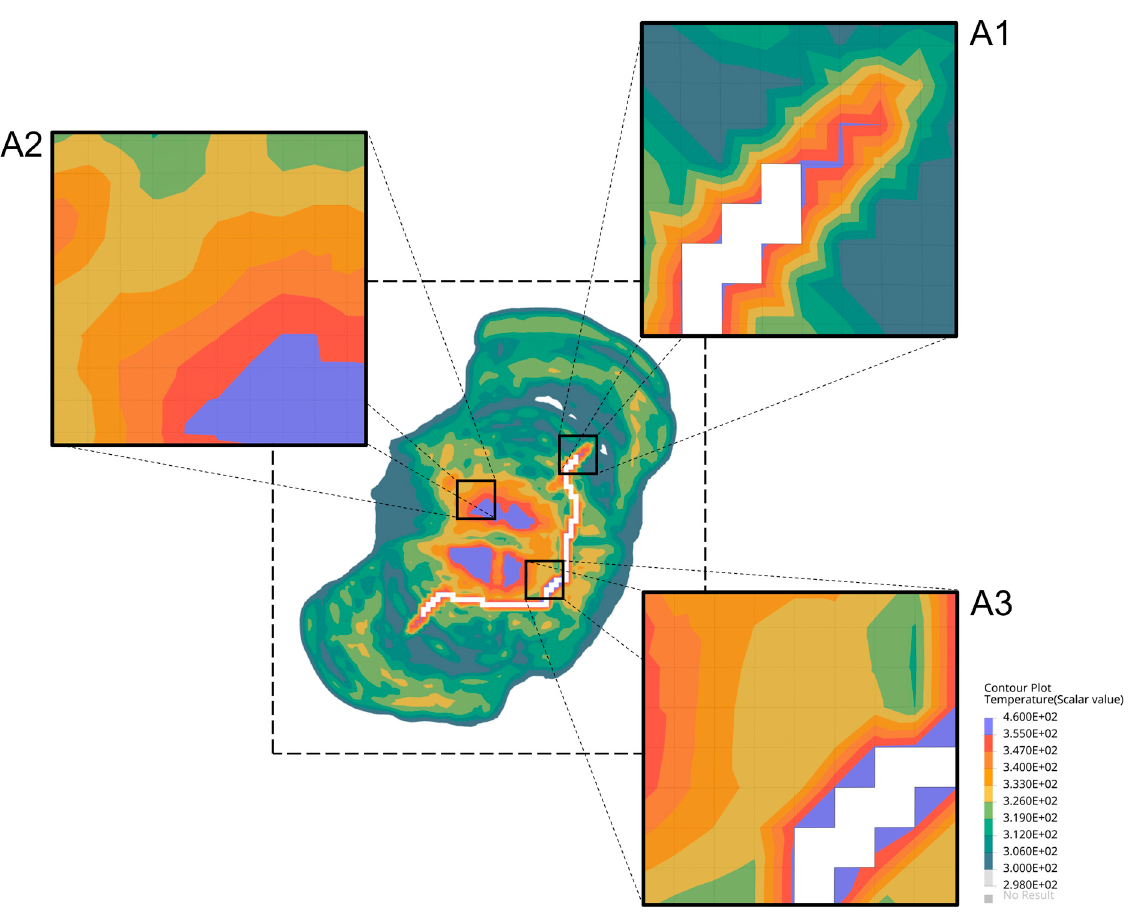
Figure 13. Temperature distribution around fracture zone (Unit Kelvin): A1—Internal fracture energy concentrated around the failure propagation path; A2—Temperature distribution around affected zone; A3—Residual thermal load in damaged composite ply;